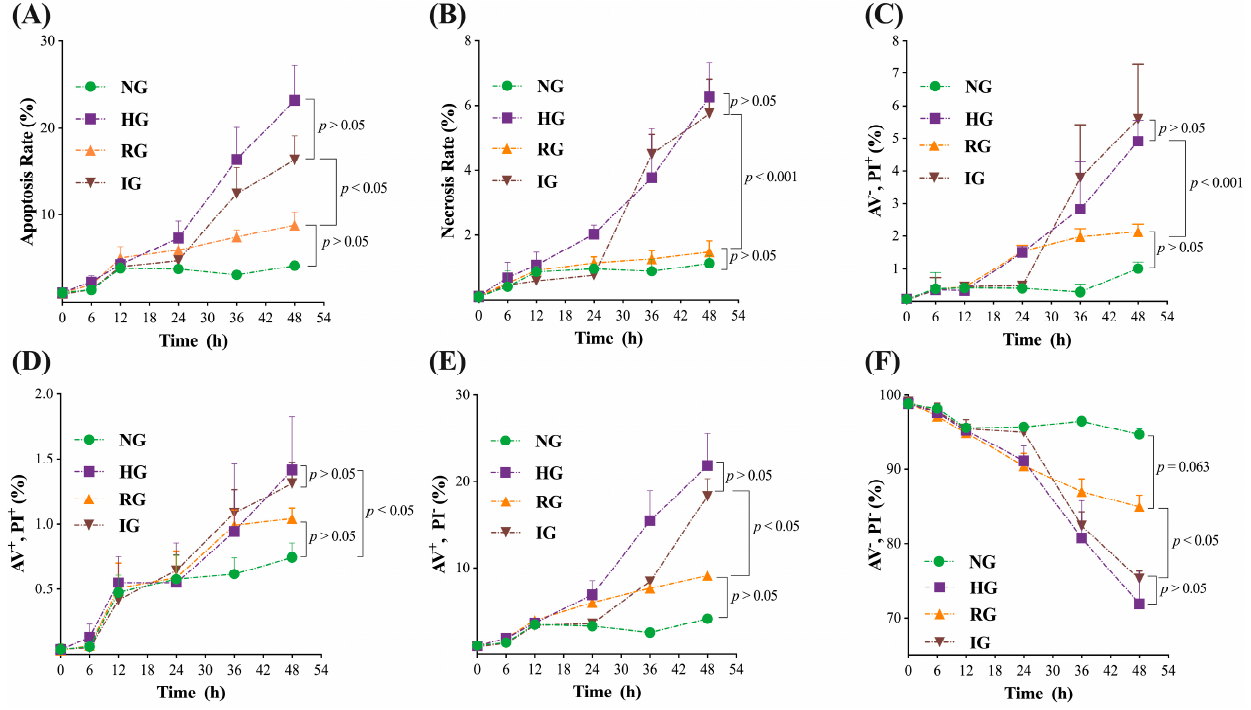
Figure 2. The dynamics of cell death in the HG and IG groups. ( A , B ) The apoptosis and necrosis rate of cultured MDBK cells at the 0th, 6th, 12th, 24th, 36th, and 48th h. ( C – F ) The cell proportion in each quadrant at the 0th, 6th, 12th, 24th, 36th, and 48th h. All experiments were repeated 3 times, and the data were presented using mean ± SD. General linear model-repeated measures .